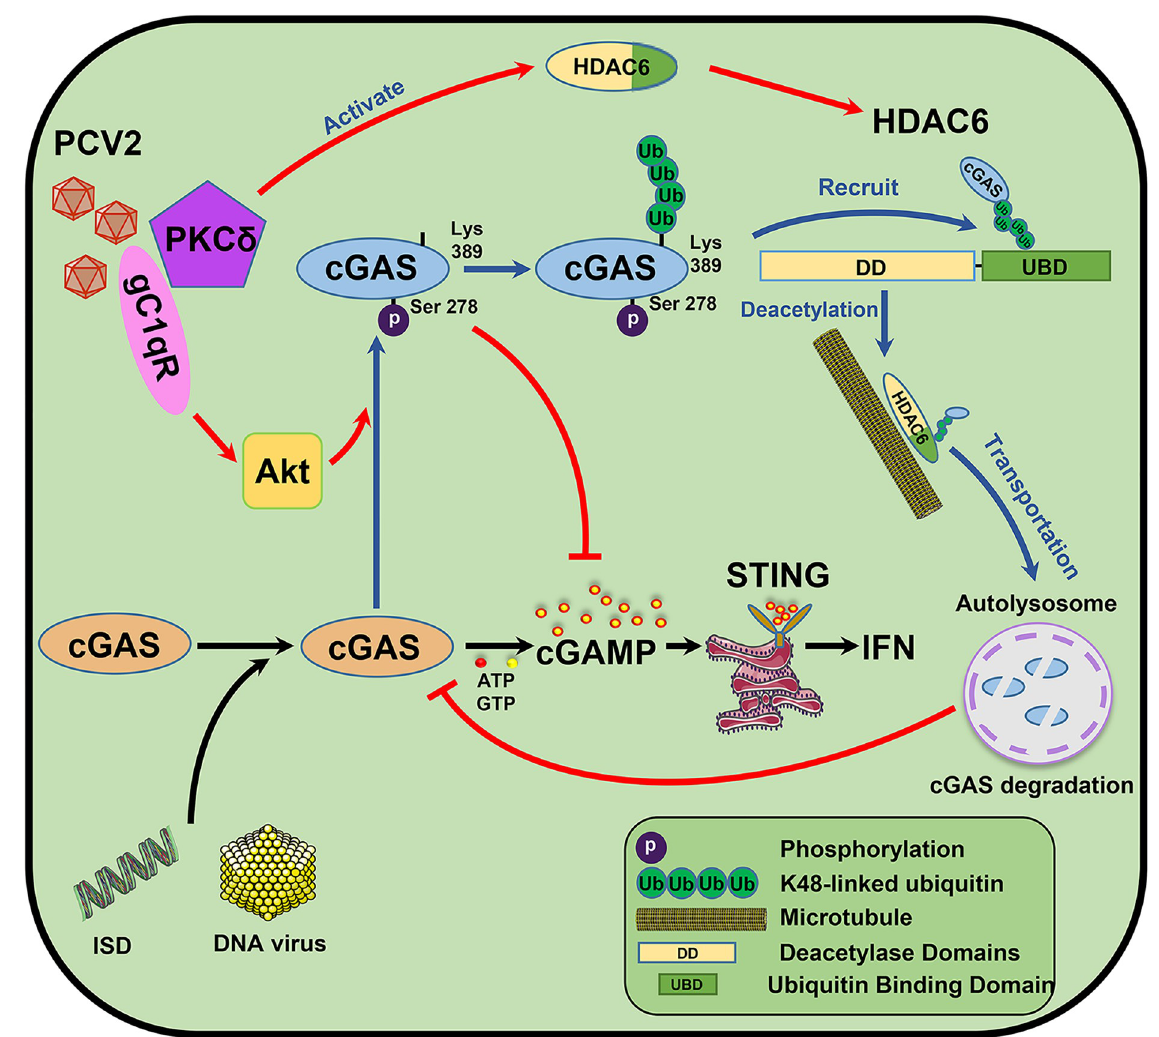
Fig 9. Model of PCV2 targeting cGAS to suppress Type I interferon production by gC1qR-mediated catalytic activity inhibition and HDAC6-mediated autophagic degradation. In the early phase of PCV2-infection, porcine cGAS is phosphorylated at S278 site via Cap binding protein gC1qR-mediated PI3K/AKT signaling activation, which directly silences the catalytic activity of cGAS to inhibit cGAMP production; Subsequently, phosphorylation of cGAS at S278 facilitates the K48-linked poly-ubiquitination of cGAS at K389, while PKC δ is phosphorylated and recruited by gC1qR to promote HDAC6 activation; then K48-ubiquitinated-cGAS proteins are recruited and transported from the cytosol to autolysosome by activated histone deacetylase 6 (HDAC6) depending on its deacetylase activity and ubiquitin-binding function, thereby eventually resulting in a markedly increased cGAS degradation in PCV2 infection-induced autophagic